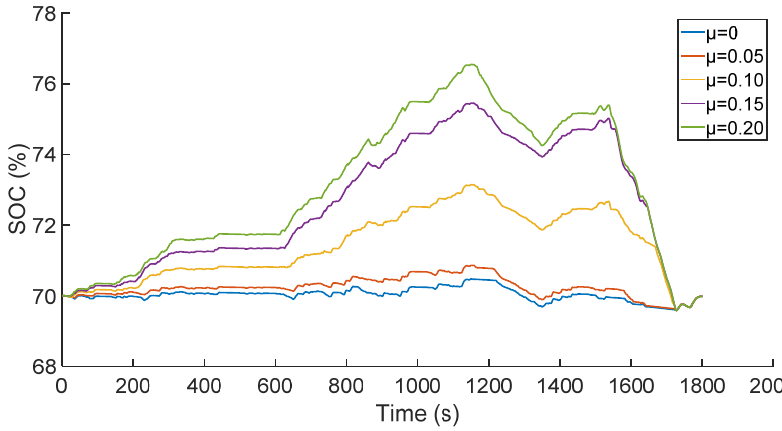
Figure A3. Three state parameters’ variation curves of µ max for emission NOx.